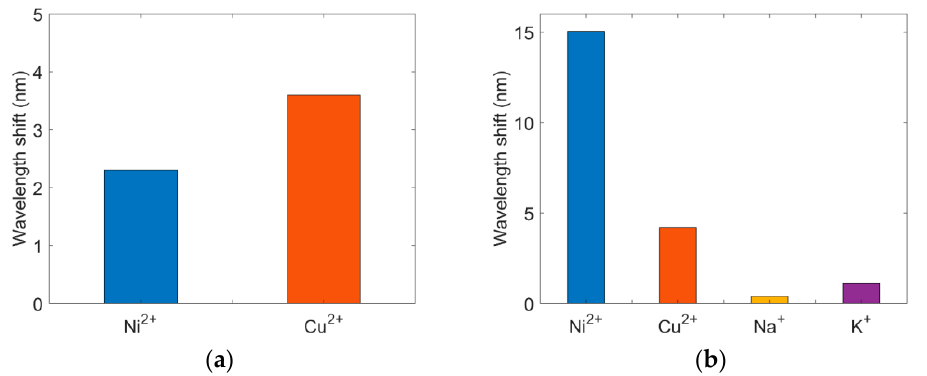
Figure 8. Selectivity of the LSPR sensor with ( a ) CS gel and ( b ) Ni 2+ –CS gel when the ion concentration is 100 μ M.